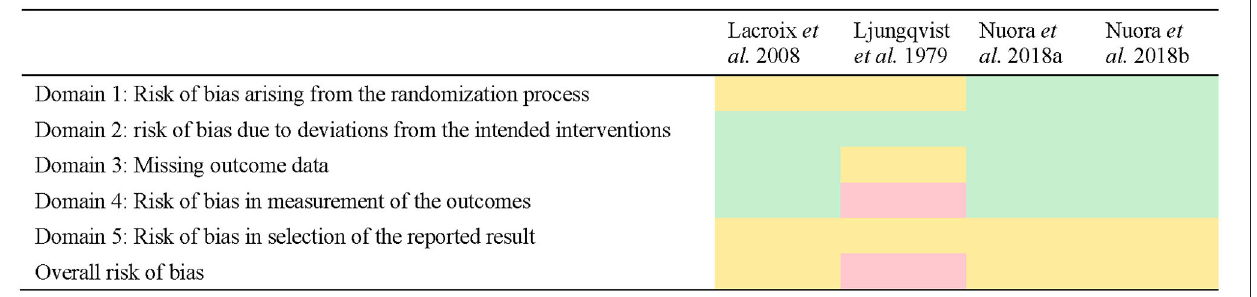
concentrations after the ingestion of micro filtered milk